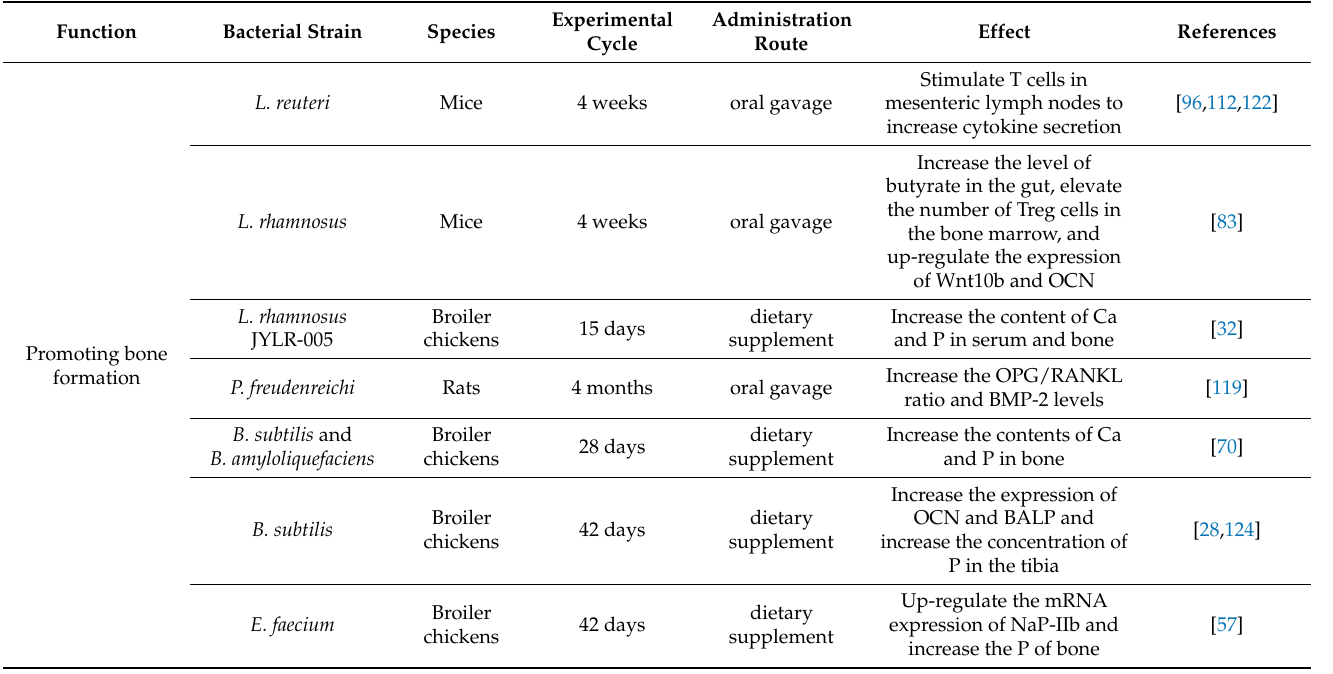
Table 1. Effect of probiotics on bone